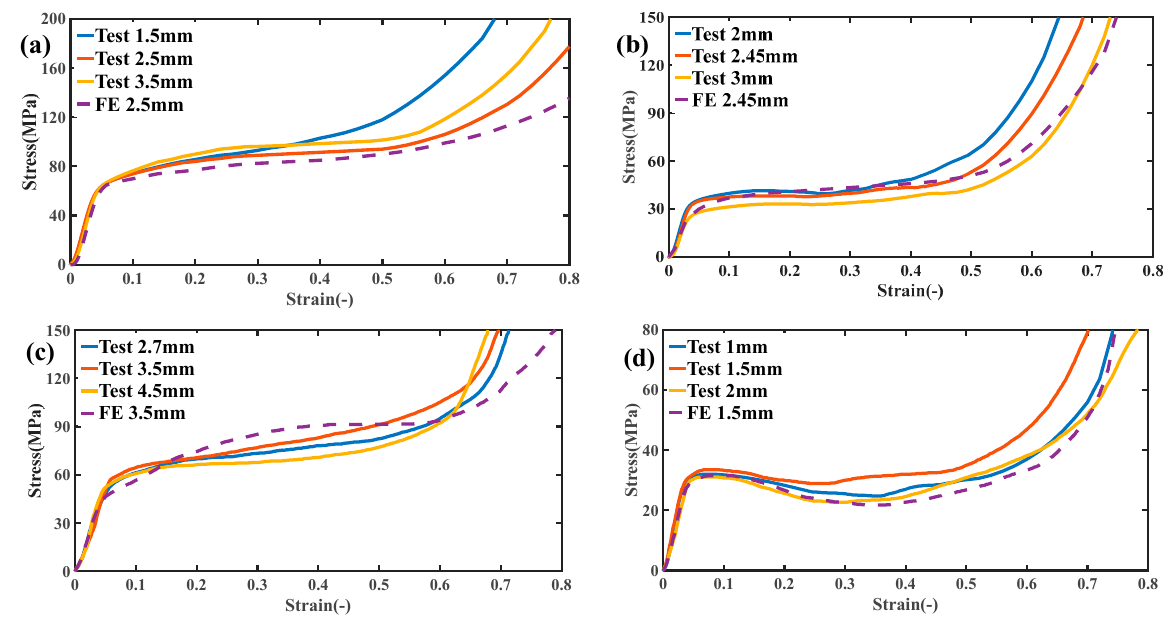
Figure 5. Experimental and numerical simulation of stress–strain curves for ( a ) Gyroid surface, ( b ) Bcc lattice structure, ( c ) Primitive surface, ( d ) truss lattice structure.